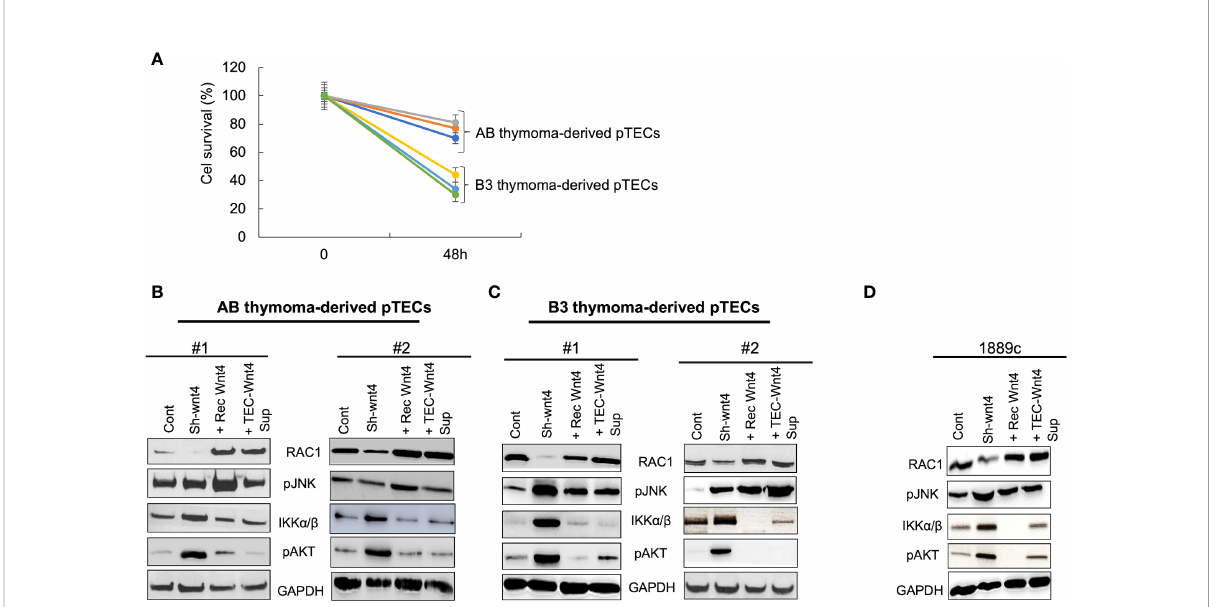
FIGURE 6 WNT4 knockdown decreased cell proliferation and RAC1 protein but not pJNK in early pTECs. Thymoma-derived pTECs and thymic carcinoma 1889c cell line were either transfected using pU6WNT4-shRNA or stimulated with either 200 ng/ml recombinant WNT4 or with the CM 25% (v: v) (Wnt4 Sup). Proteins of RAC1, pJNK, IKK a / b , and pAKT were extracted from the cells and analyzed by western blot after transfection of 48 h or after four days of stimulation. (A) : Cell proliferation analysis in AB and B3 thymoma derived pTECs (n = 6) after transfection for 48 h with pU6-WNT4-shRNA. Cell proliferation was measured using MTT assay; (B) : Protein analysis of RAC1, pJNK, IKK a / b , pAKT, in pTECs derived from 2 cases of AB thymomas; (C) : Protein analysis of RAC1, pJNK, IKK a / b , pAKT, in pTECs derived from two cases of B3 thymomas; (D) : Protein analysis of RAC1, pJNK, IKK a / b , pAKT in thymic carcinoma cell line, 1889c. GAPDH is used as loading control for cytosolic protein